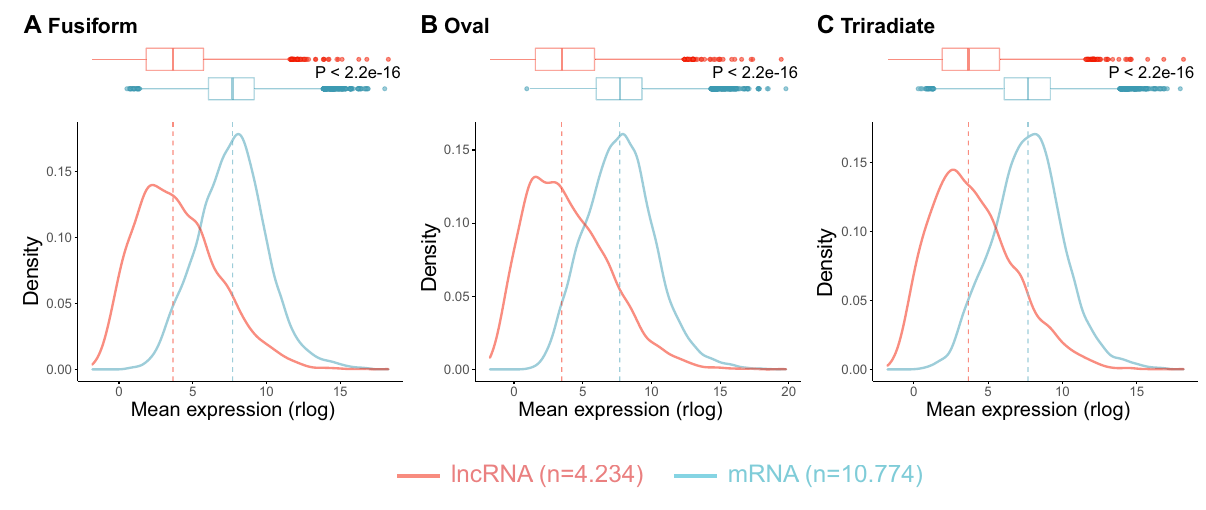
Figure 1. Expression level differences between coding and noncoding transcripts in P. tricornutum morphotypes. We measured the expression level differences between mRNAs and lncRNAs within the three transcriptomes: ( A ) Fusiform, ( B ) Oval, and ( C ) Triradiate. The sets of coding and non-coding were first filtered (filtering out lowly expressed transcripts) using the CPM method from the NOISeq package, and the number of transcripts retained for downstream analysis is displayed in parentheses. The data were then normalized using the rlog function from the DESeq2 package. Figures were made using the “Wes Anderson” color palette “Zissou1” in R (https:// github. com/ karth ik/ wesan